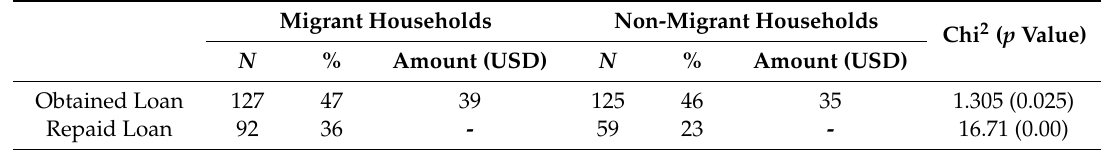
Table 9. Loan status.